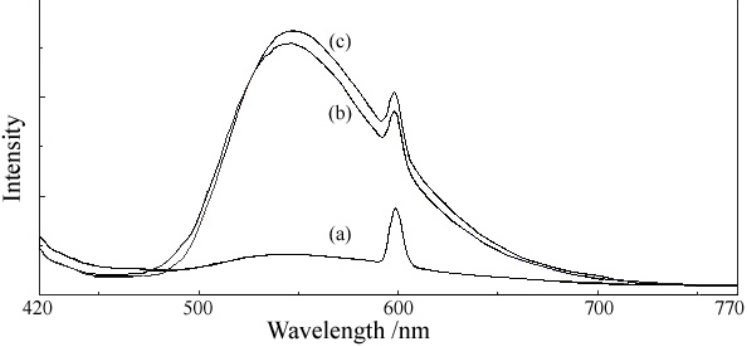
Figure 8. The emission spectra at λ